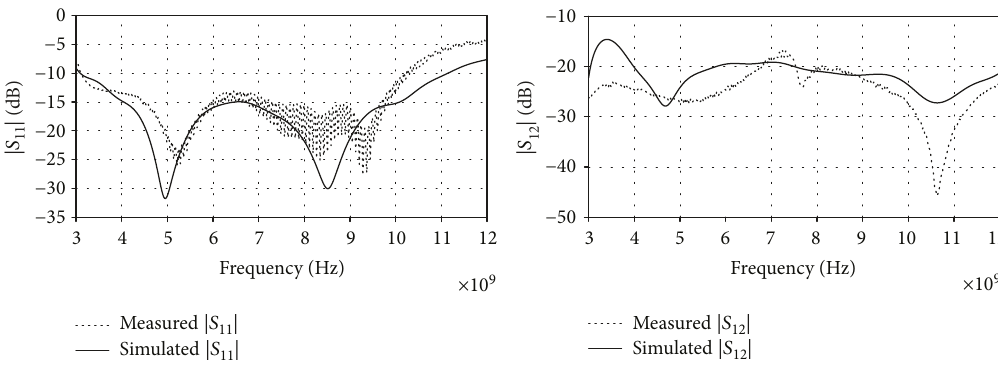
Figure 10: The measured and simulated S -parameters of the proposed